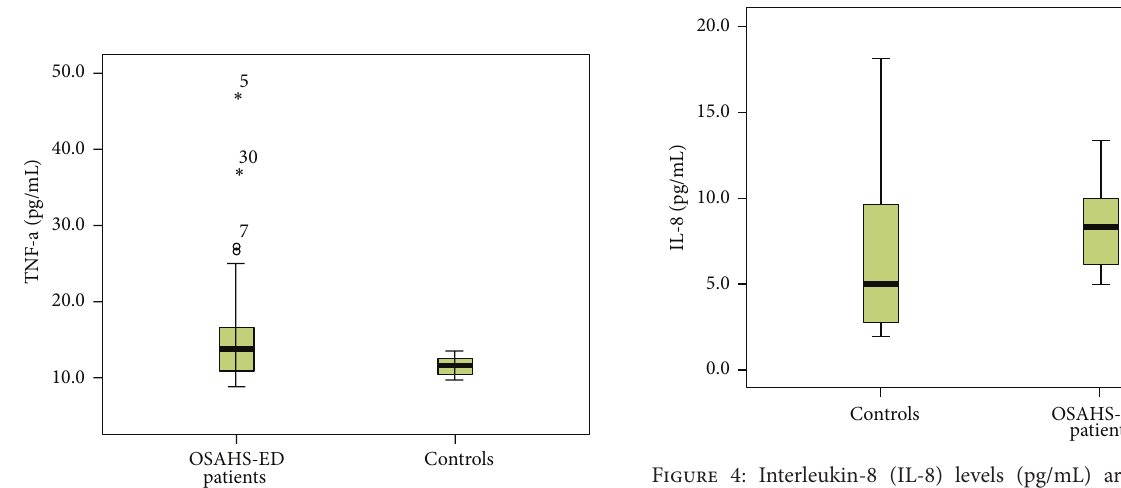
Figure 4: Interleukin-8 (IL-8) levels (pg/mL) are significantly higher in OSAHS patients with ED (OSAHS-ED) compared to controls ( 𝑃 = 0.034 ). IL-8 concentrations are shown as median (interquartile range) in the